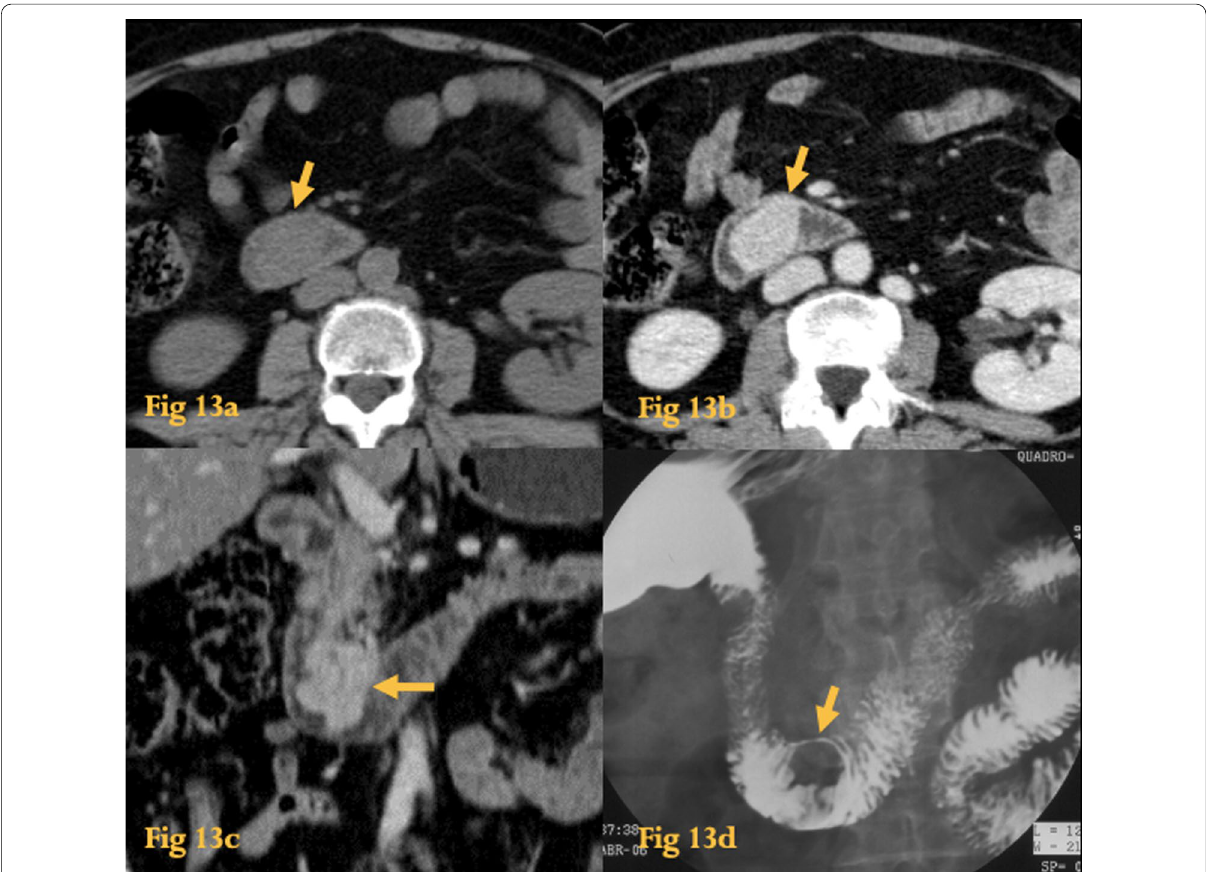
Fig. 13 GIST. Unenhanced abdominal CT ( a ) shows an endoluminal homogeneous soft‑tissue lesion on the transition D2–D3. Abdominal CT with iv contrast ( b , c ) shows homogeneous enhancement of the lesion (arrow). Barium study ( d ) shows a well‑circumscribed round intramural mass (arrow) in the transition D2–D3. Histopathological study of the resected specimen revealed a benign